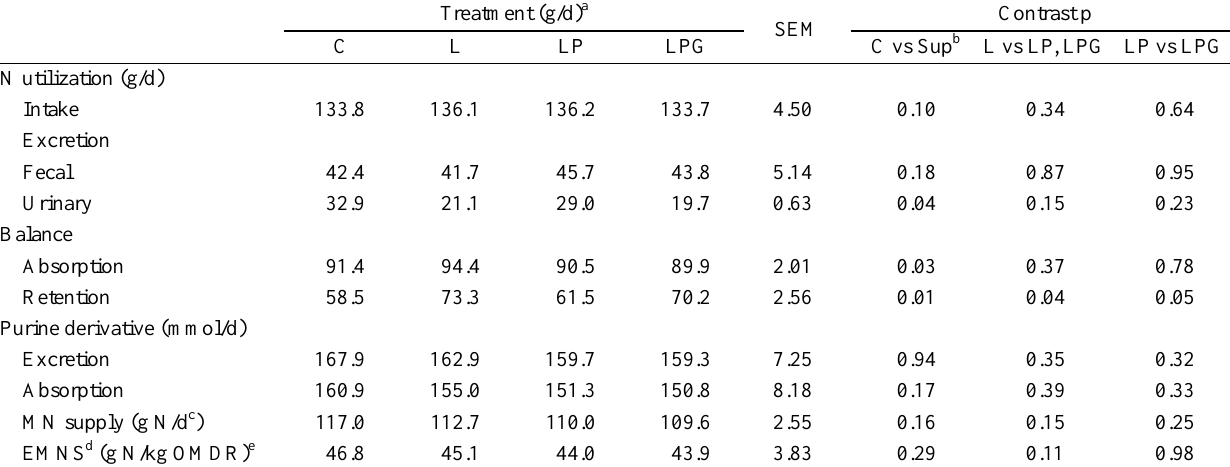
Table 5. Effect of herb dietary on N balance and urinary purine derivatives in cattle Treatment (g/d) a